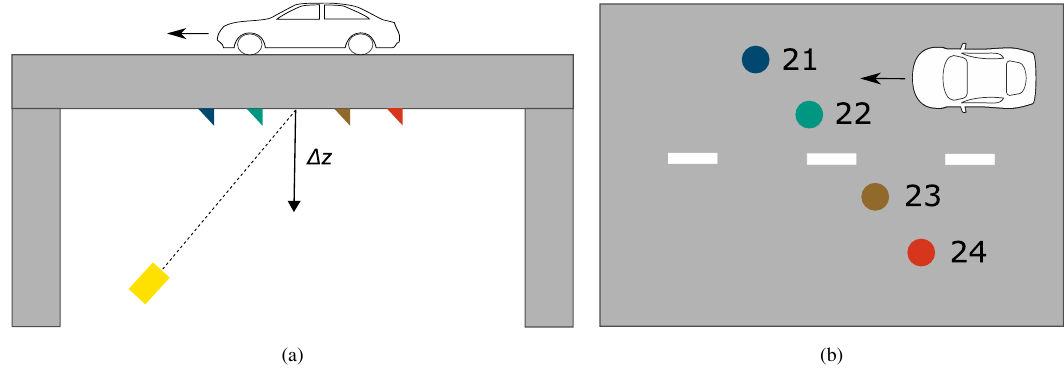
Figure 1. (a) Lateral view of a prototypical bridge during a GBR measurement. The GBR (yellow) measures the displacement in line of sight (LOS) visualized as a dotted line. This LOS measurement, then, is transformed into vertical displacement ∆ z . The colored triangles represent corner reflectors, which have been installed to achieve a higher reflectivity. (b) Top view of the same measurement setup as in (a). It shows the two lanes on top of the bridge as well as the offset of the range bins 21 to 24 . Table 1. Detailed information on the selected bridges. Structure Type Fields